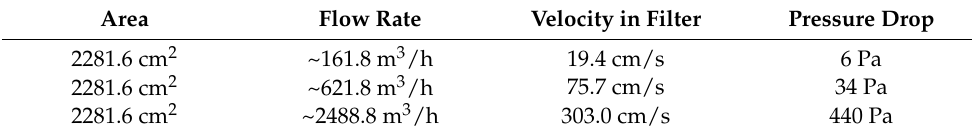
Table 4. Conditions used in the filtration tests and pressure drop determination.